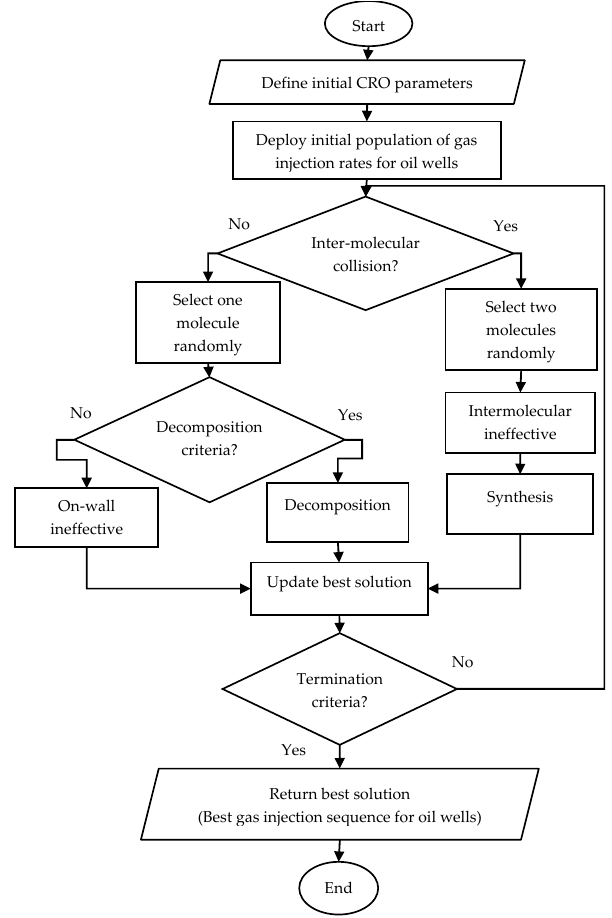
Figure 2. Flowchart of the proposed CRO approach.